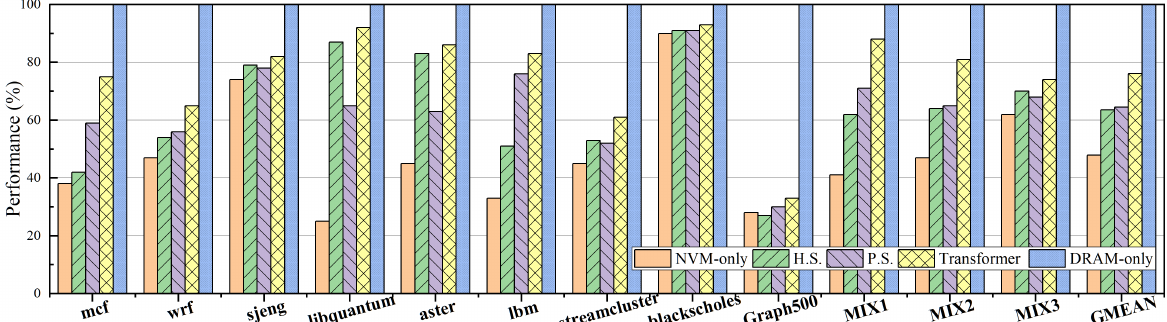
Figure 9. The normalized performance of applications in different memory systems.